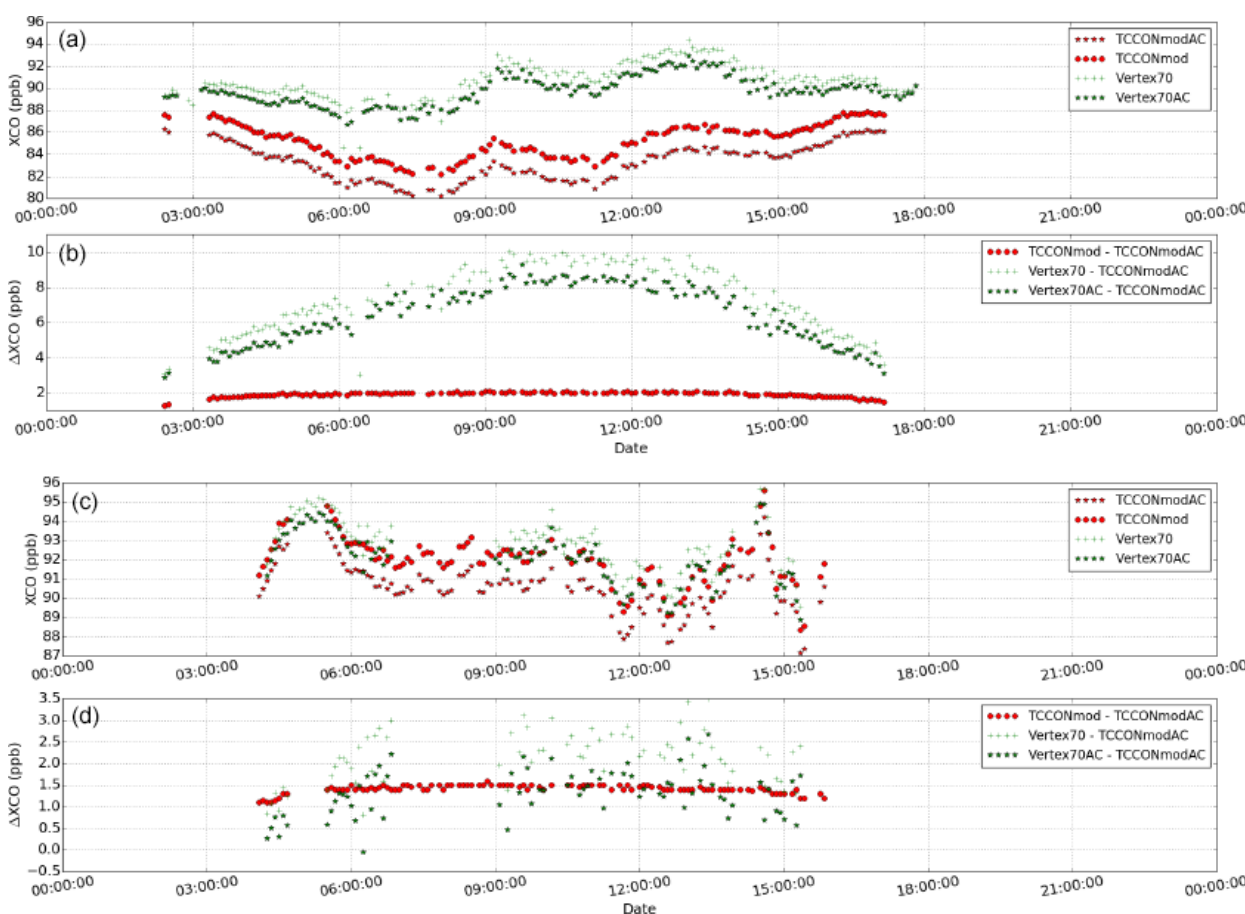
Figure A6. XCO values plotted for TCCONmod and Vertex70 retrievals with the TCCON a priori and with a modified a priori (calculated using in situ, AirCore, and TCCON map files; labelled with AC at the end) are shown in panel (a) , and their difference is shown in panel (b) for measurements performed on 15 May 2017 at Sodankylä. Panels (c) and (d) show the same plots for 28 August 2017. Table C1. Statistics of the intercomparison results for HR125LR vs. TCCON for measurements performed in 2017 with SZA < 75 ◦ . The values provided are the mean bias ± the standard deviation and the correlation coefficient ( r ). The statistics in the first row cover the full year of measurements in 2017, while those in the second row cover the measurements performed between 6 July and 12 September